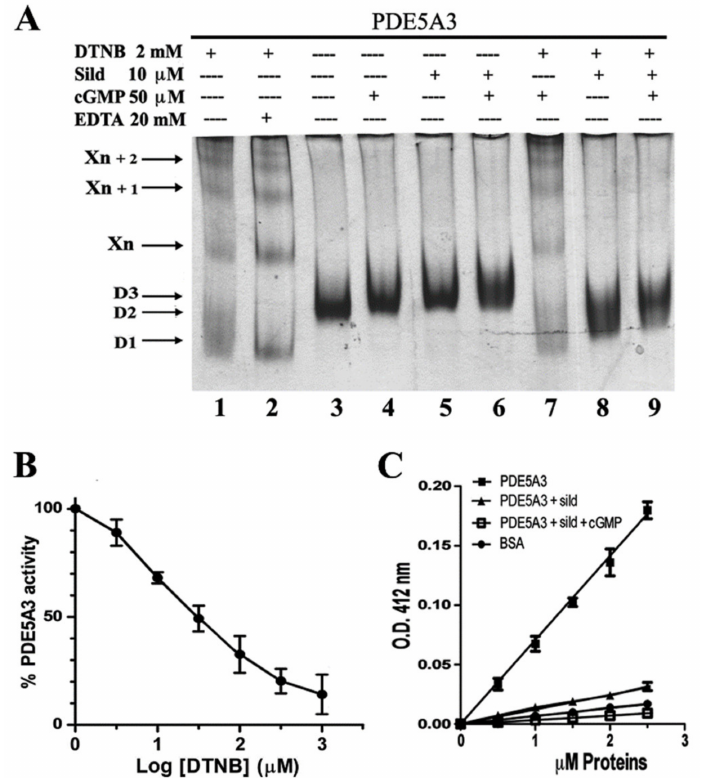
Figure 6. Characterization of Cys reactivity in MmPDE5A3. ( A ) Native PAGE migration of the isoform following incubation at 30 ◦ C for 1 h with DTNB, cGMP and sildenafil. EDTA, cGMP and sildenafil were preincubated for 1 h prior to addition of DTNB and were followed by 1 extra hour of incubation. ( B ) Inhibition of MmPDE5A3 activity with increased amounts of DTNB. ( C ) Titration of cysteine thiols of PDE5A3 isoform alone with sildenafil or sildenafil plus cGMP using DTNB. Bovine serum albumin (BSA) thiol groups were also titrated as a